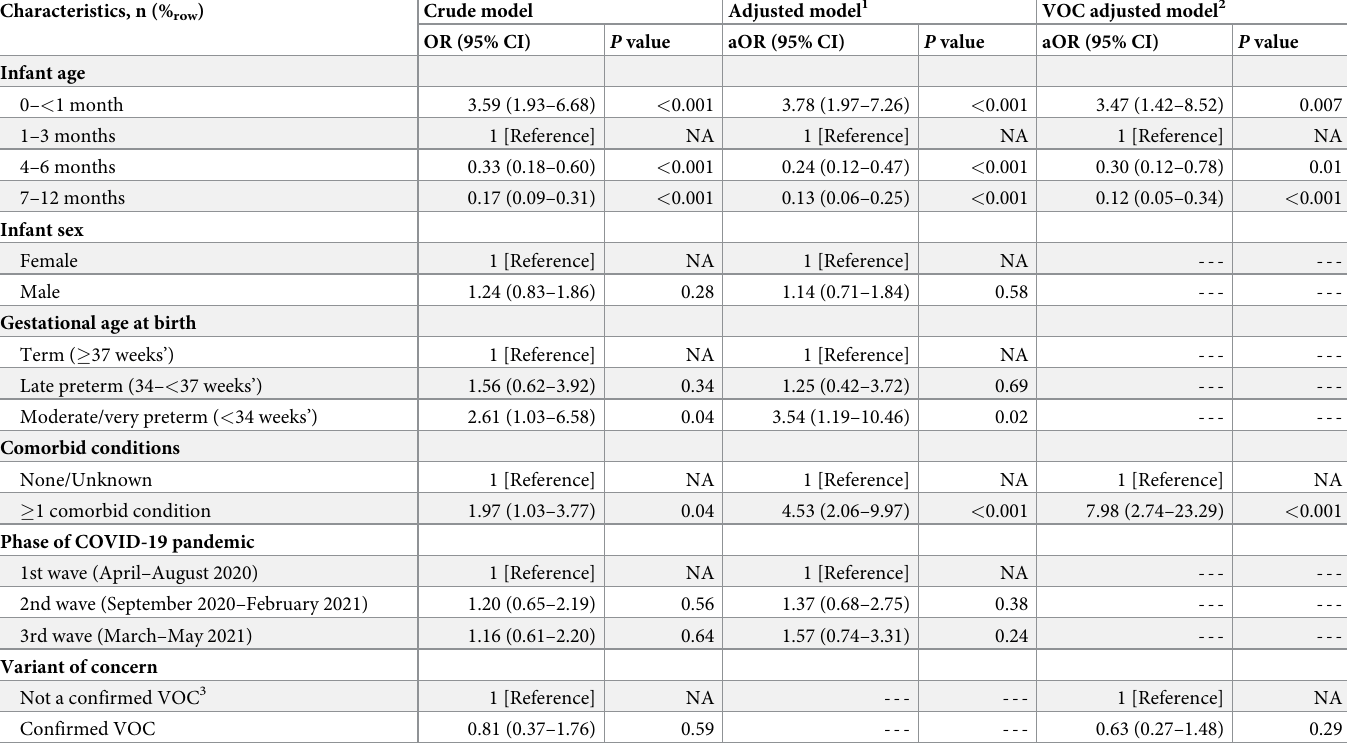
Table 2. Logistic regression analysis of infants’ characteristics associated with COVID-19 hospital